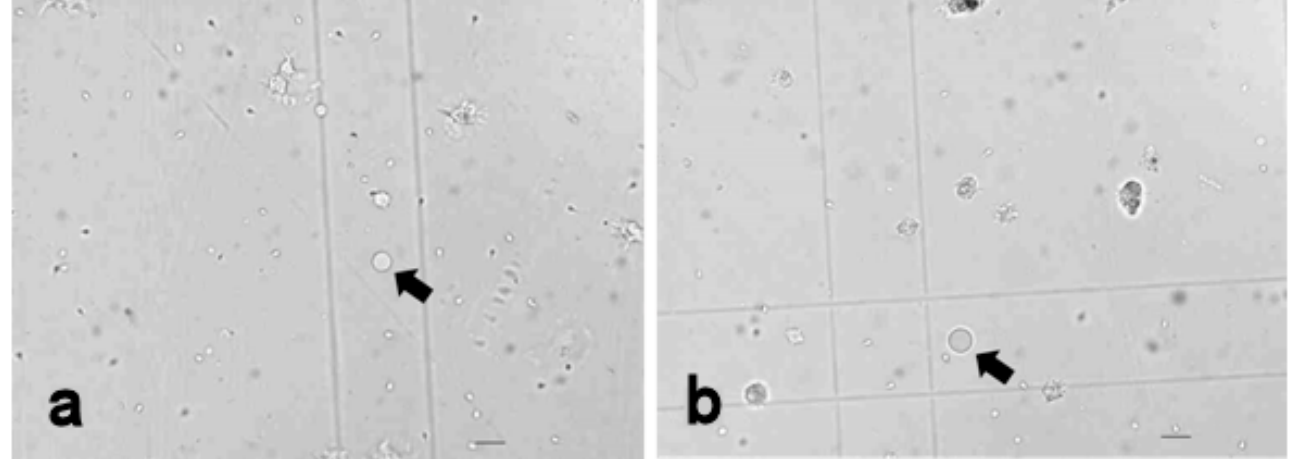
Figure 7. Micrographs of the haemolymph of mussels exposed for 48 h to 0.1 mg L − 1 PMMA microparticles of diameters ( a ) 10 μ m and ( b ) 50 μ m. Microparticles are indicated by the arrows. Scale bar 20 μ m.